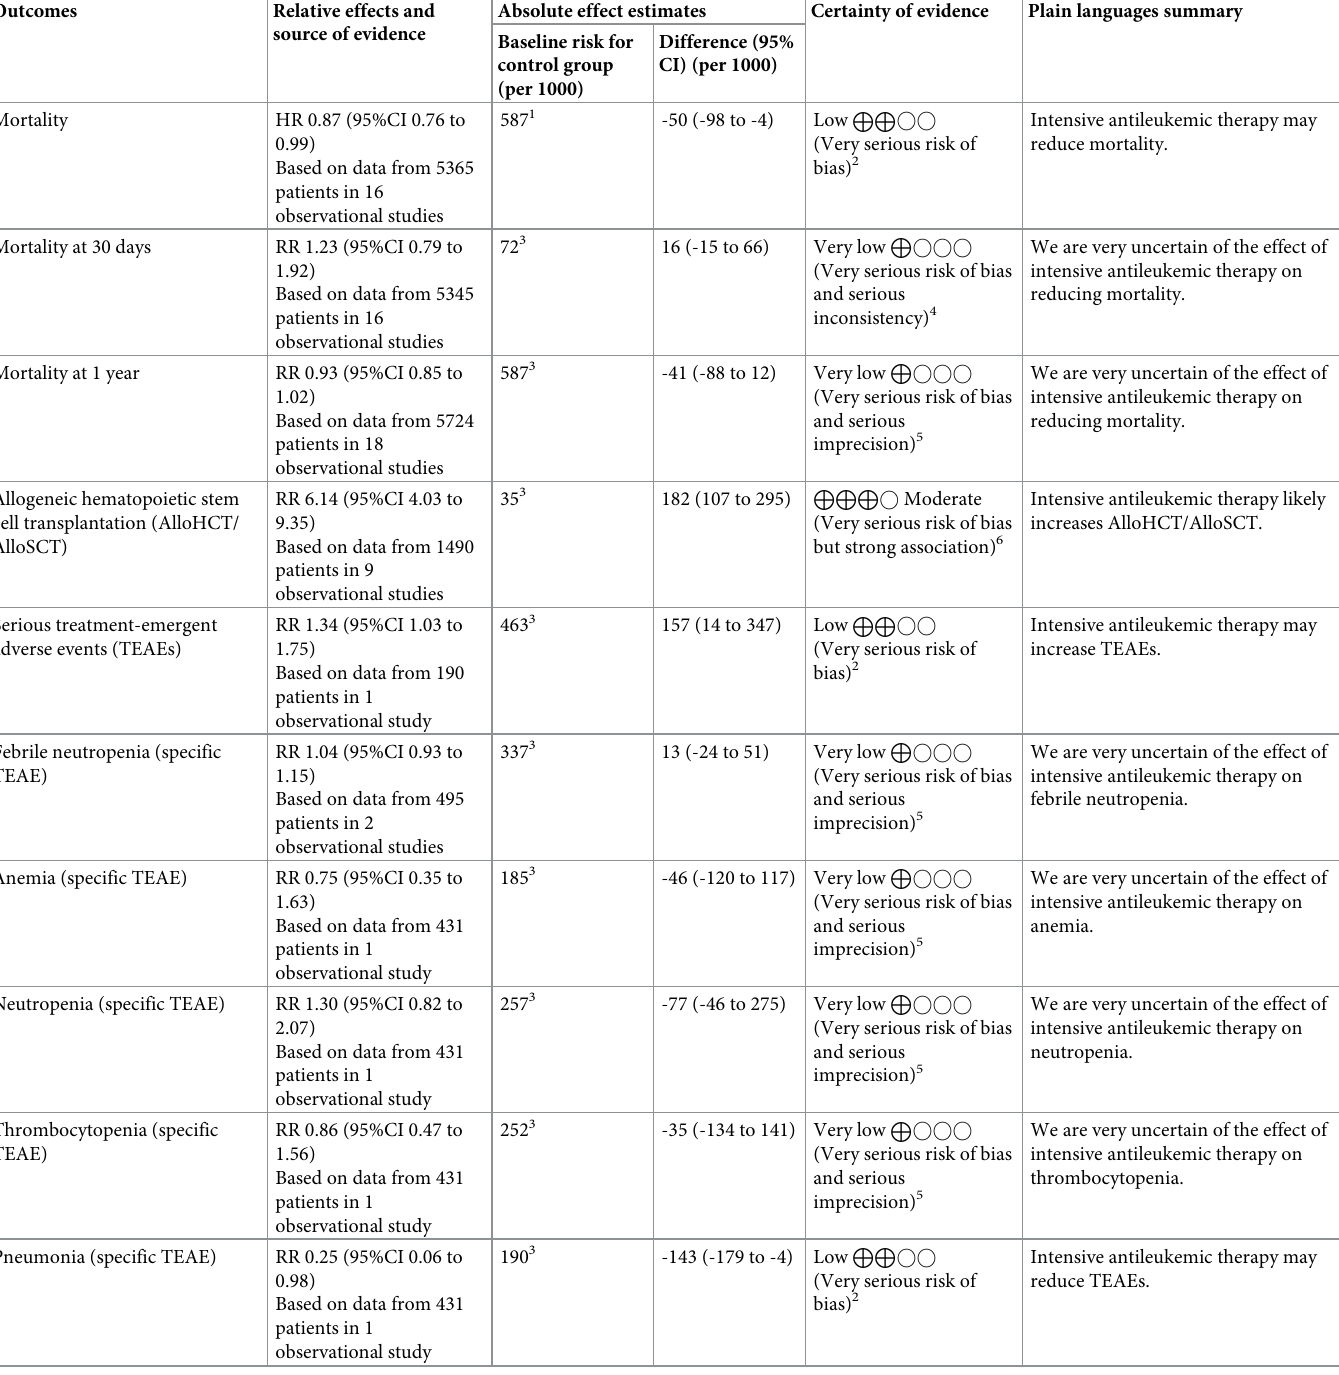
Table 2. GRADE summary of findings: Intensive versus less-intensive antileukemic therapy among older patients with acute myeloid leukemia, evidence from observational